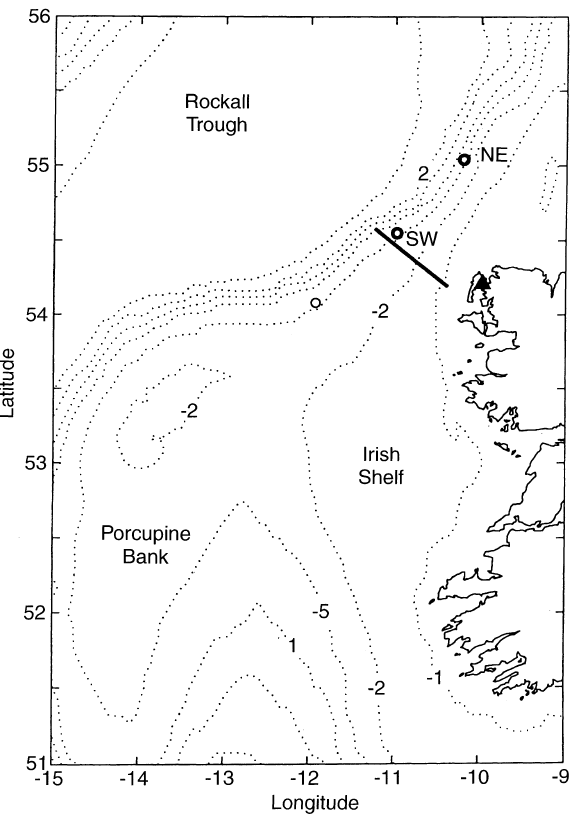
Fig. 1. Location map showing position of the two moorings (SW, NE), both marked ‘o’, and position of a 3rd lost mooring. The filled triangle marks the position of the tide gauge and the nearby Irish Meteorological Station. The line indicates extent of the CTD transect. Contours are marked in km